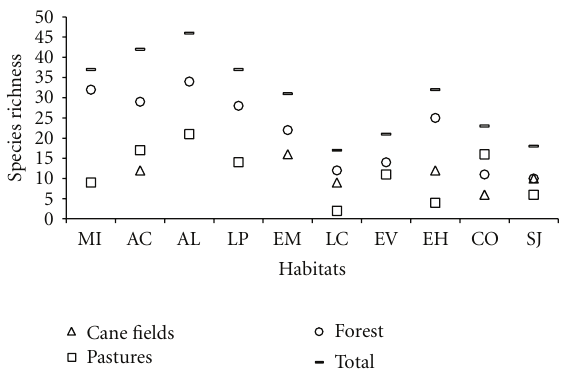
Figure 1: Richness of ant species broken down by habitat at 10 sites ordered geographically from North to South. MI (Miralindo), AC (Aguas Claras), AL (Alejandr´ıa), LP (Las Pilas), EM (El Medio), LC (Las Chatas), EV (El V´ınculo), EH (El Hatico), CO (Colindres), and SJ (San Juli´an).